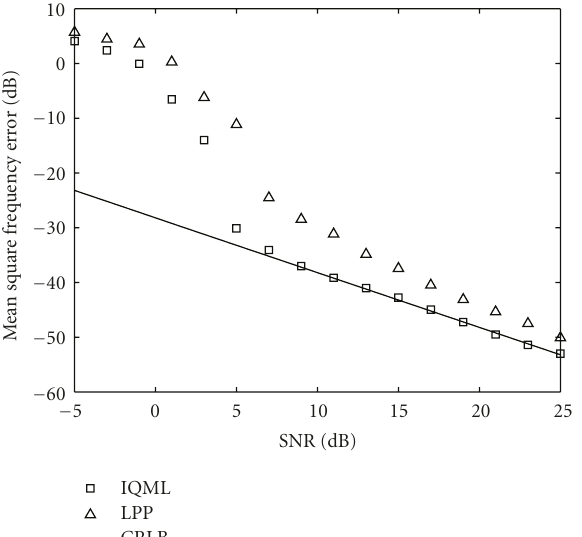
Figure 18: MSE for ω 1 of multiple complex sinusoids.